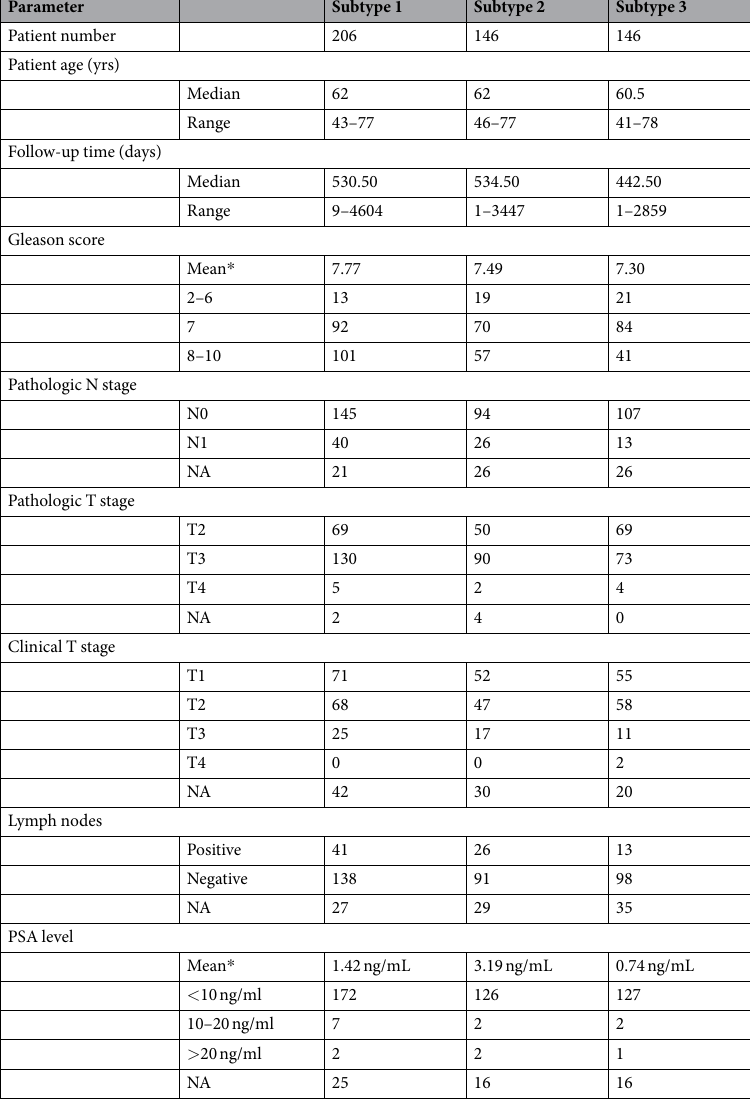
Table 3. Clinicopathological characteristics for each molecular subtype in the robust clustering. ( * In this table, all of the median values for three molecular subtypes were same, so the mean values were used to replace the median